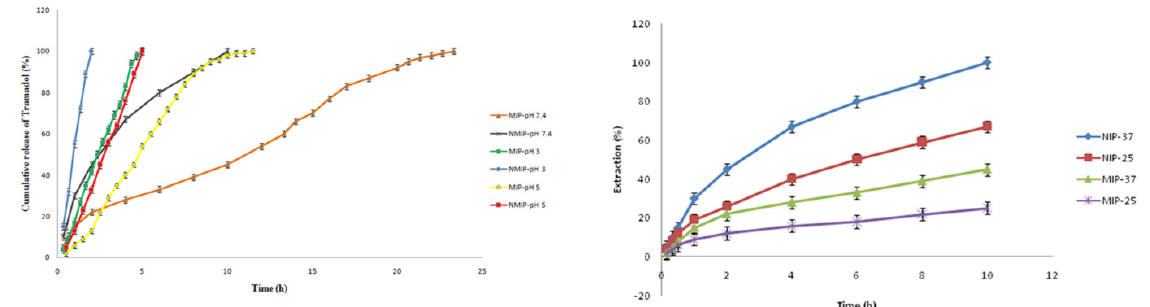
Figure 12. Release profile of 50 mg tramadol imprinted polymer at 37°C and various pH 3.0, 5.0 and 7.4. Media volume: 5 mL (mean±S.D., n=3)